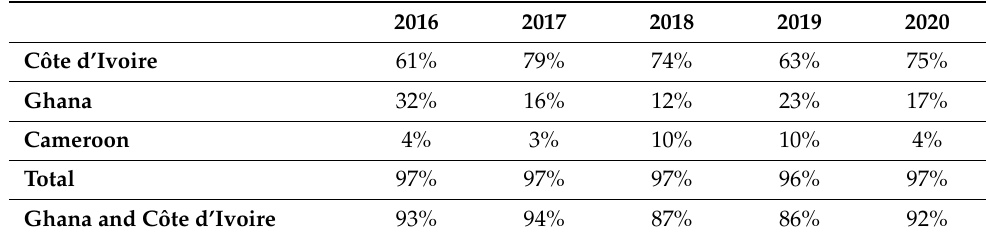
Table 1. Turkish Imports of Cocoa Beans (%) by Country of